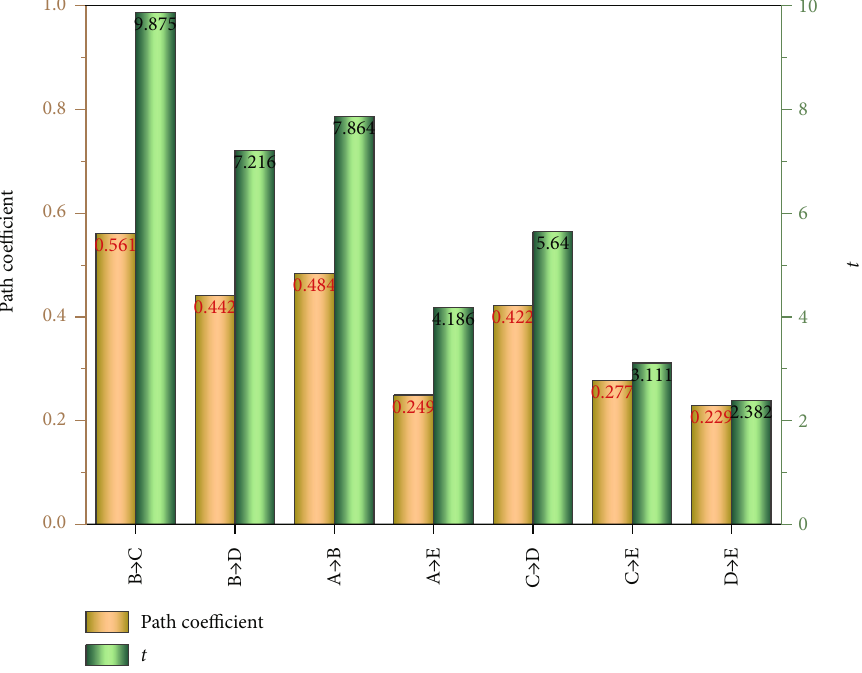
Figure 8: Path coe ffi cient between latent